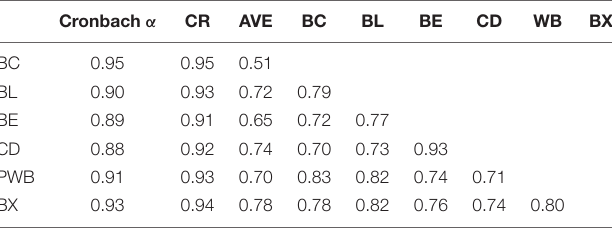
TABLE 3 | Internal consistency and discriminant validity (heterotrait-monotrait, HTMT, and ratio) evaluation.